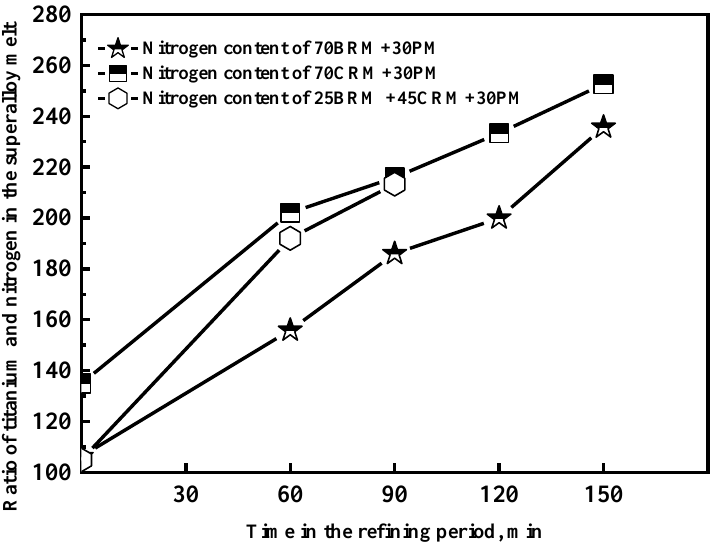
Figure 12. Ratio of titanium and nitrogen in the superalloy melt in the refining period.